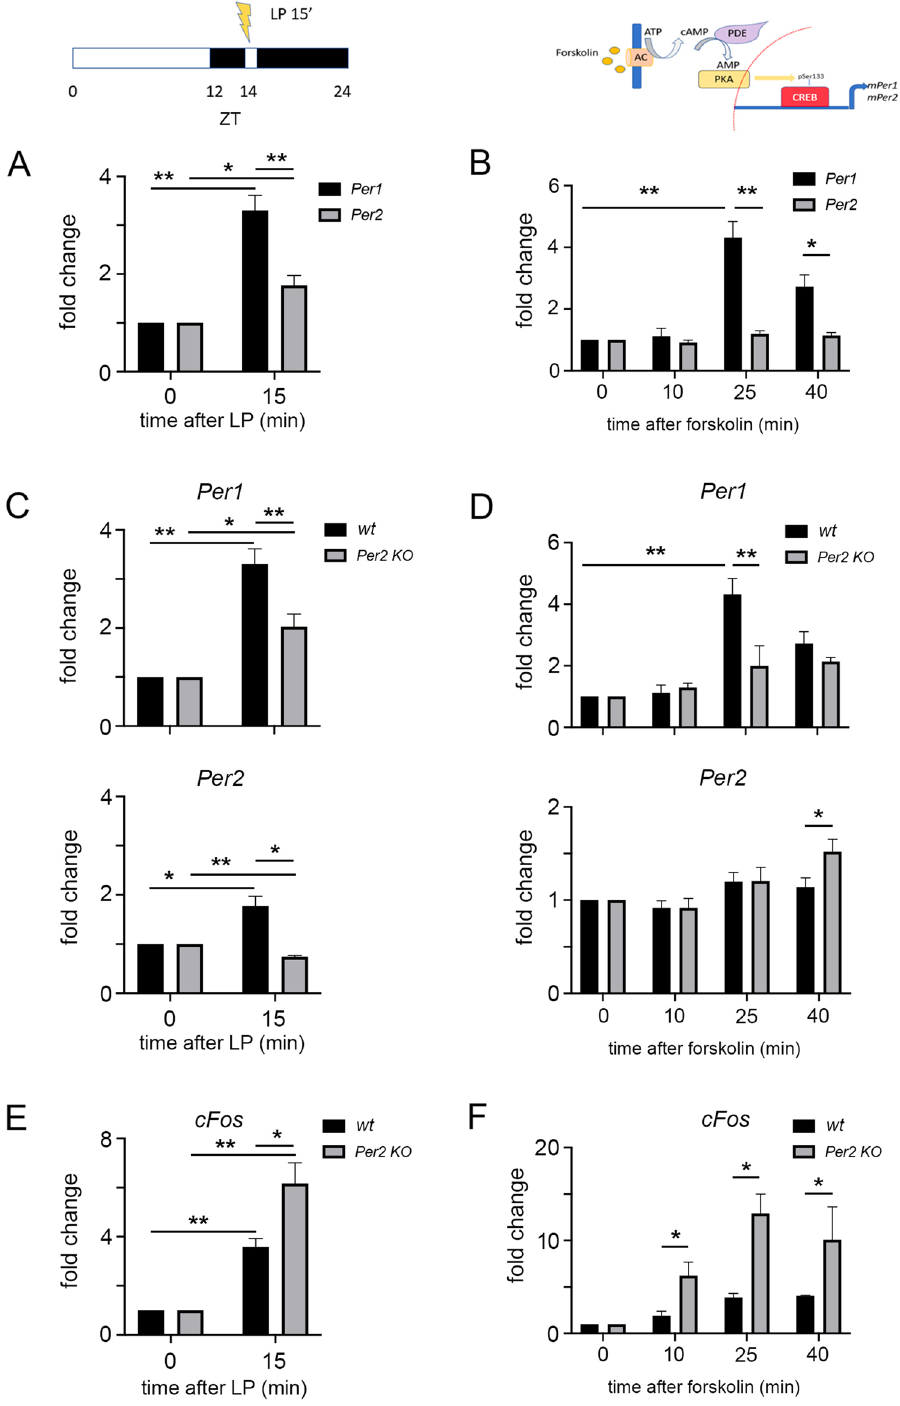
Figure 1. Induction of Per1 , Per2 , and cFos gene expression after light or forskolin stimulation. The diagram top left indicates the light treatment protocol of mice ( A , C , E ) and the top right diagram shows the forskolin treatment of cells ( B , D , F ). ( A ) Fold change of Per1 (black bars) and Per2 (grey bars) pre-mRNA expression in the SCN after a 15 min light pulse (LP) applied at ZT14. Values are the mean ± SEM. Student’s t-test with Welch’s correction, n = 3, * p < 0.05, ** p < 0.01. ( B ) Fold change of Per1 (black bars) and Per2 (grey bars) pre-mRNA expression in NIH 3T3 cells after forskolin treatment. Values are the mean ± SD. Student’s t-test with Welch’s correction, n = 3, * p < 0.05, ** p < 0.01. ( C ) Fold change of Per1 (top panel) and Per2 (bottom panel) pre-mRNA expression in the SCN of wild type (wt, black bars) and Per2 knock-out (KO, grey bars) mice after a 15 min light pulse (LP) applied at ZT14. Values are the mean ± SEM. Student’s t-test with Welch’s correction, n = 3, * p < 0.05, ** p < 0.01. ( D ) Fold change of Per1 (top panel) and Per2 (bottom panel) pre-mRNA expression in immortalized wt or Per2 KO fibroblast cells after forskolin treatment. Values are the mean ± SD. Student’s t-test with Welch’s correction, n = 3, * p < 0.05, ** p < 0.01. ( E ) Fold change of cFos expression in the SCN of wt (black bars) and Per2 KO (grey bars) mice after a 15 min light pulse (LP) applied at ZT14. Values are the mean ± SEM. Student’s t-test with Welch’s correction, n = 3, * p < 0.05, ** p < 0.01. ( F ) Fold change of cFos expression in immortalized wt or Per2 KO fibroblast cells after forskolin treatment. Values are the mean ± SD. Student’s t-test with Welch’s correction, n = 3, * p <